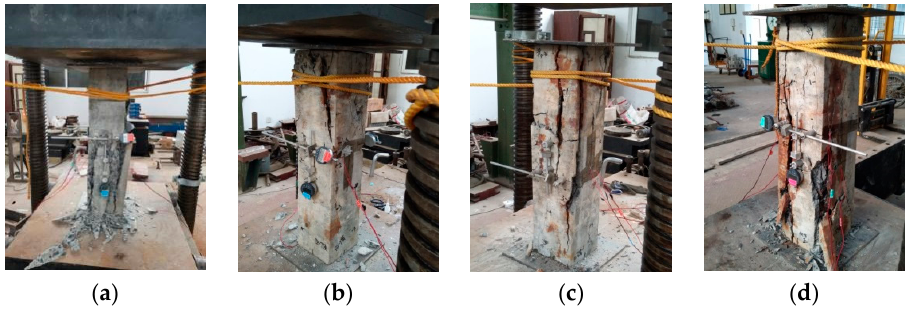
Figure 9. The destruction patterns of concrete columns. ( a ) GZ0; ( b ) GZ5; ( c ) GZ10; ( d )